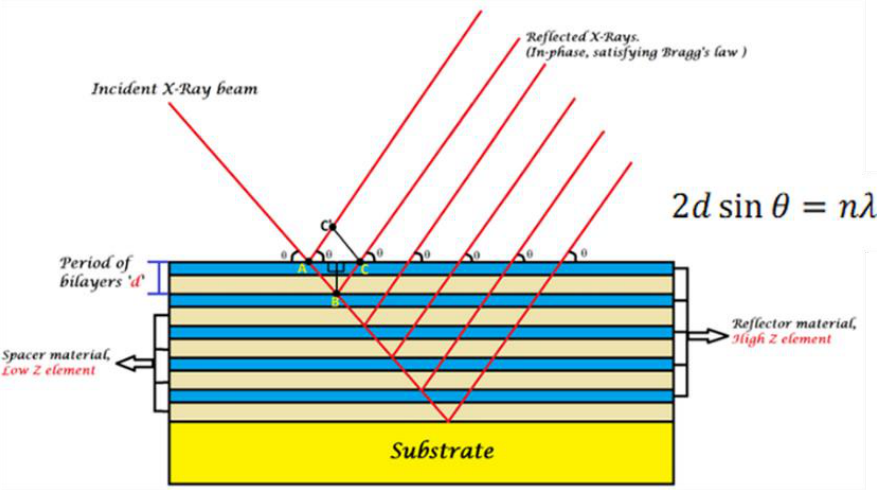
Figure 3. Schematic view of constructive interference from interfaces of a multilayer. PMMs are known as artificial Bragg crystals having alternate layers of “light” and “heavy” materials (Figure 2); they are also called “spacer” and “absorber.” The periodicity of such a structure is almost half of the working wavelength when the angle of incidence (AOI) is near 90 ◦ [17,19]. PMMs realize high reflectivity by the constructive interference of light reflected from the interfaces of assembled layers of different optical contrasts. It is important to note that the refractive index in the X-ray range is complex and equals 1 − δ + i β , where δ is the refractive index decrement and β represents the absorption index. Therefore, at any given wavelength, materials with a high δ and a low β act as a reflective layer, whereas those with a low δ and a low β serve as spacer layers. An array of layers with high and low δ (alternated reflectors and spacers in a stack) provides optical contrast, as shown in Figure 3. Both the reflector and spacer layers need a low β to minimize any loss of light by absorption. For instance, at a wavelength of above 12.8 nm, molybdenum and silicon can serve as a pair of reflector/spacer materials and work together to serve as